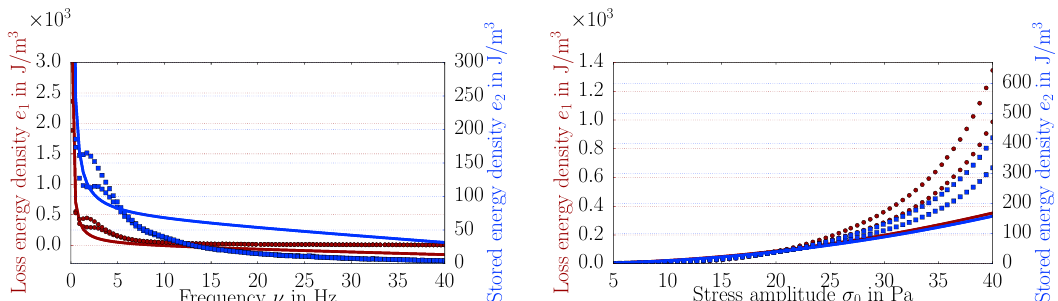
Figure 3. Linear model, loss (red circles) and stored (blue squares) energies obtained from the measurement; corresponding fit curves as continuous lines. Left: Frequency variation by fixed amplitude, σ 0 = 40Pa. Right: Amplitude variation by fixed frequency, ν =